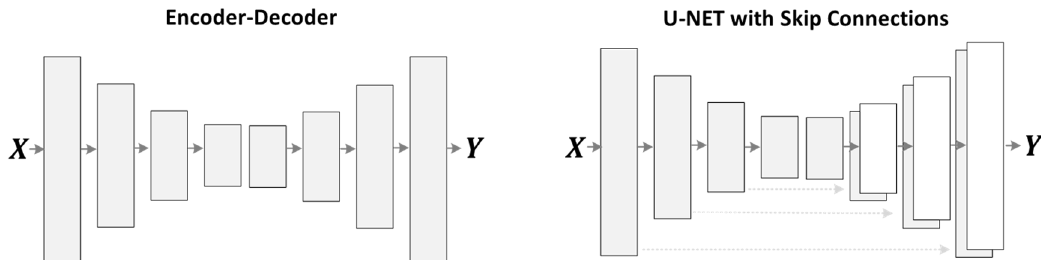
Figure 4. Different approaches for image denoising tasks.